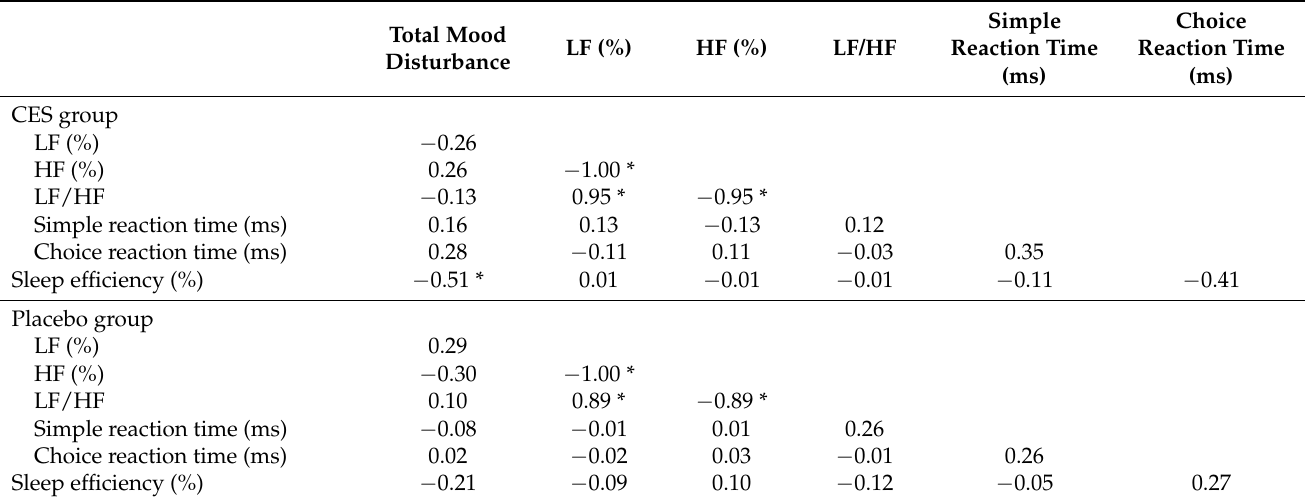
Figure 3. Changes in sleep efficiency slopes during the study. Table 5. Within-subject correlation between the related variables in CES and placebo